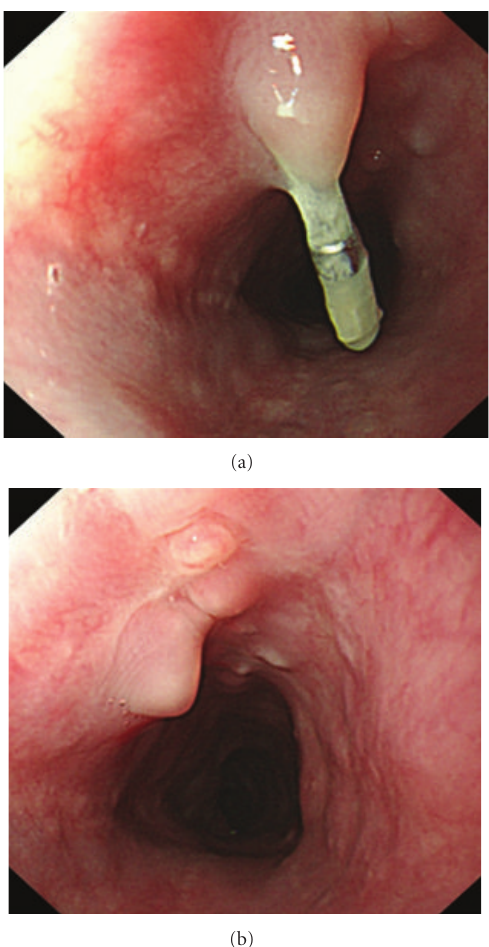
Figure 3: Follow-up esophagoscopy. On postoperative month 2, the follow-up esophagoscopy demonstrated a well-healed